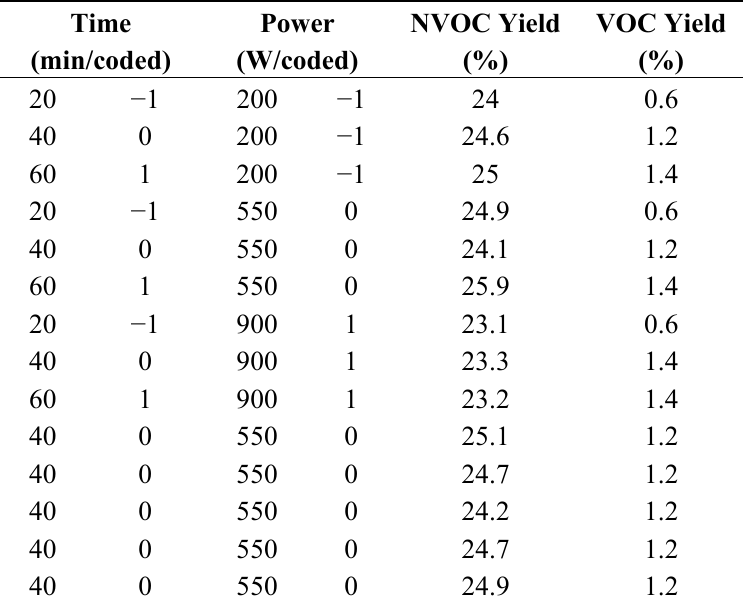
Table 1. Variables involved in the Central Composite Design (CCD) and response obtained.